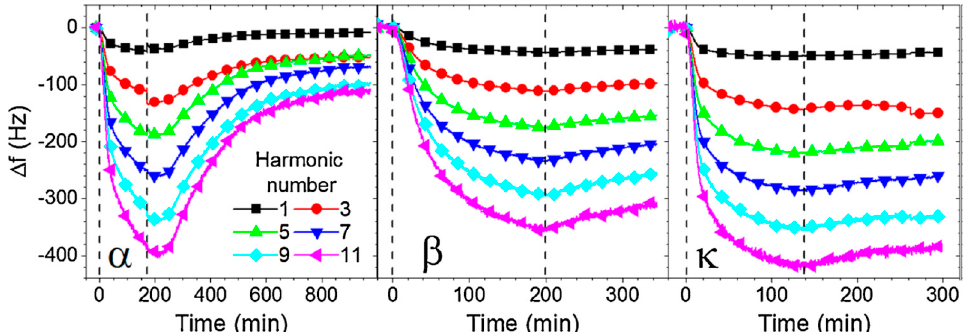
Figure 6. Kinetics of casein adsorption and removal from the SiO 2 surface, as measured by a frequency shift ( Δ f) of the 1st–11th odd harmonics of the QCM-D. Exposure and removal of α -casein (left panel), β -casein (middle panel) and κ -casein (right panel) are marked by the first and second vertical dashed lines, respectively. Reproduced with permission of Elsevier from Tatarko et al. [62].